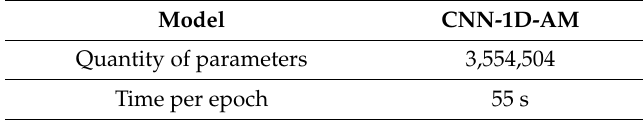
Table 3. Quantity of parameters and training time per epoch for CNN-1D-AM.